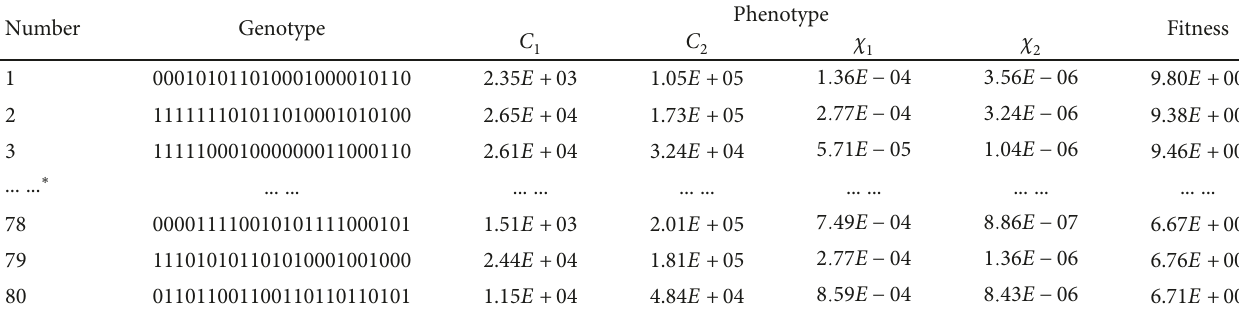
Table 1: Initial population.